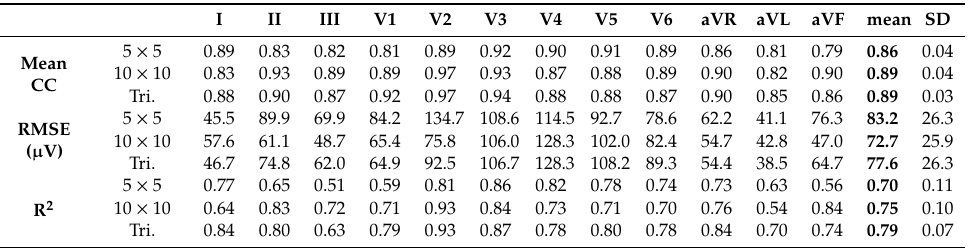
Table 5. CC, RMSE and R-square values of each 12-lead ECG for the minCC approach with the ANN